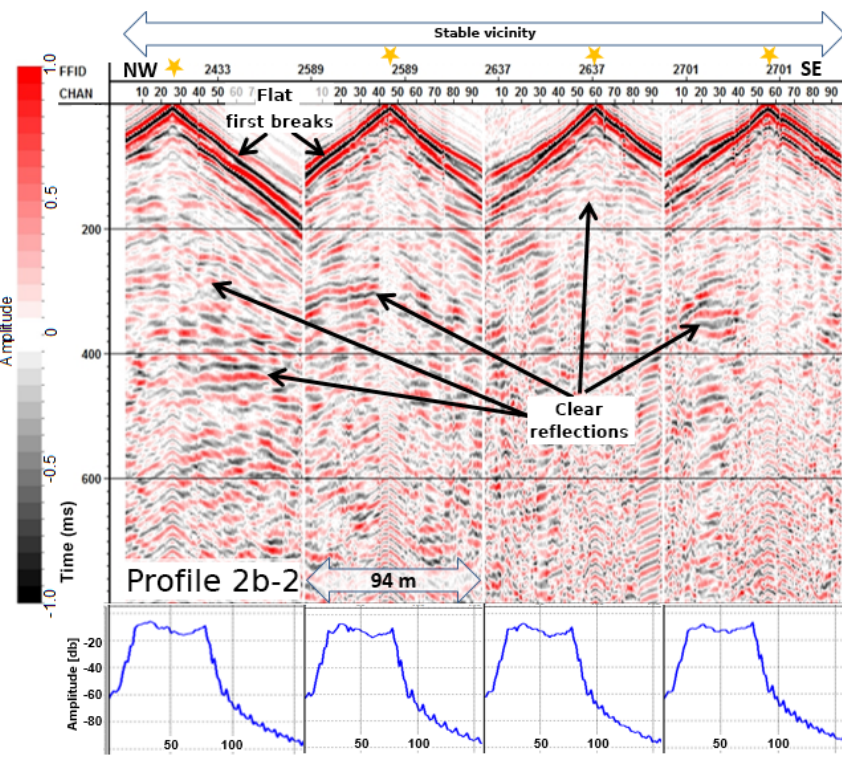
Figure 6. Examples of recorded shot gathers (AGC of 220ms window; amplitude scaling and bandpass filter (18-20-78-82Hz) applied) in the time domain along profile 2b-2 (labelling as in Fig. 5). Good signal quality of first breaks and reflections mirrors a rather unaffected signal propagation in the subsurface, which correlates to the sinkhole-unaffected vicinity at the surface. Reflection signals up to 400ms in time represent layer responses from 70m depth (applying a 350ms − 1 shear wave propagation velocity). Below, mean amplitude spectra of the time window 0–400ms for each record are